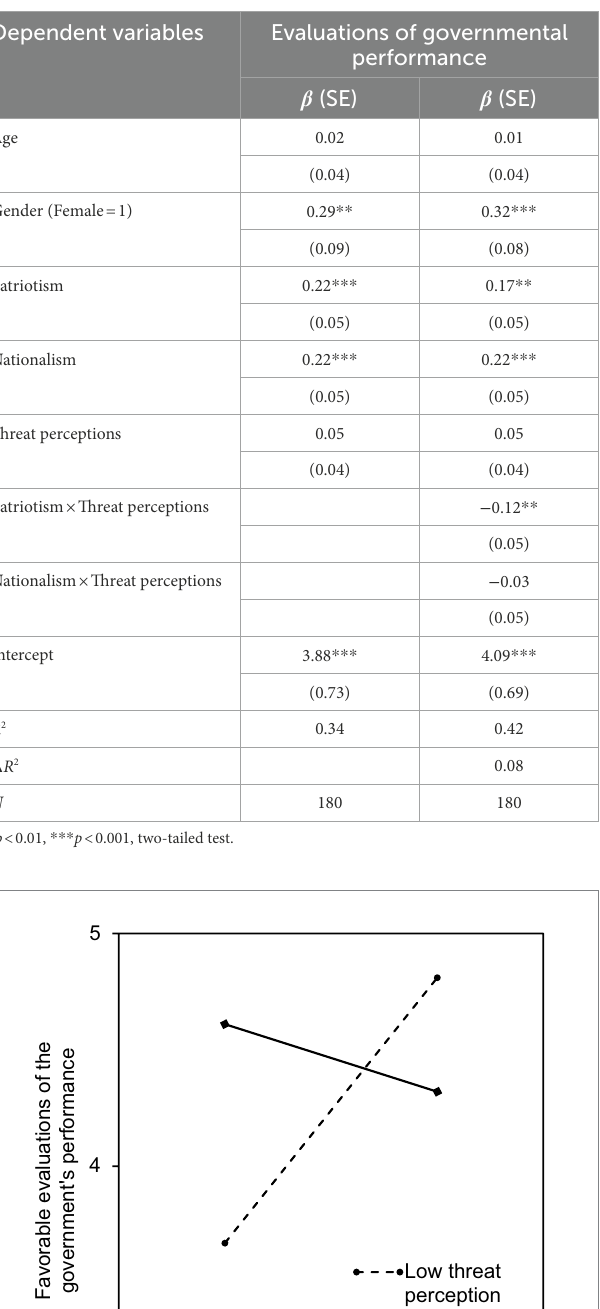
TABLE 2 The effect of patriotism, nationalism, and threat perceptions on evaluations of the government’s performance during the COVID-19 pandemic.